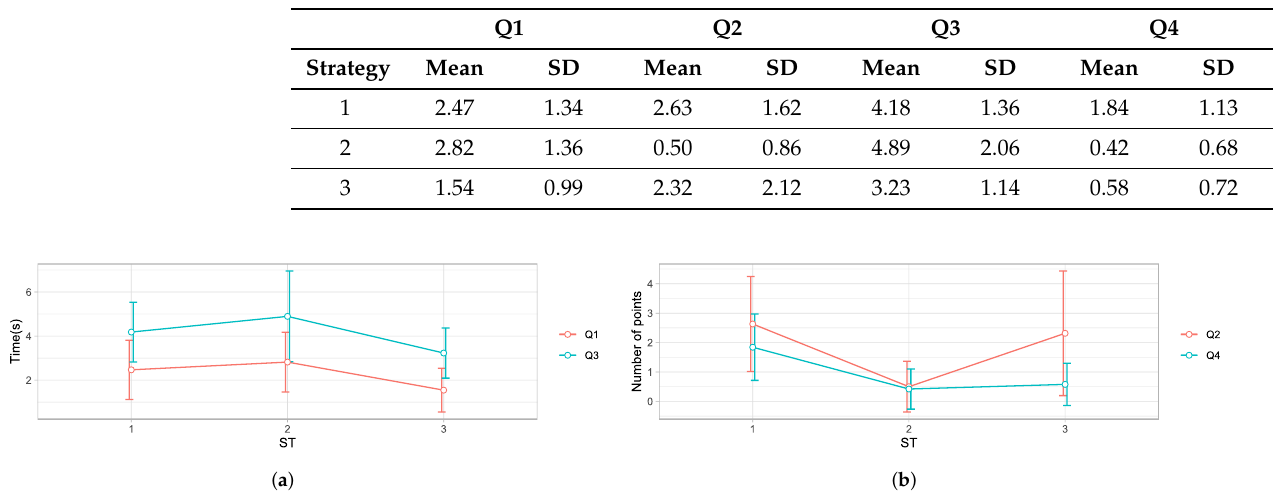
Figure 13. Results for each strategy. ( a ) Q1: Time taken for each strategy to detect the desired point. Q3: Time taken by the robot to reach the desired point. ( b ) Q2: The number of intermediate points detected by each strategy. Q4: The number of intermediate stopping points of the